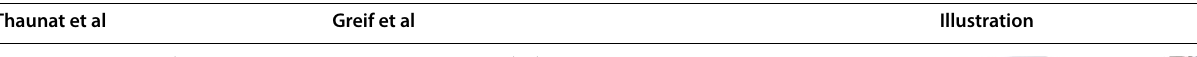
Table 1 Correlation between Thaunat’s and Greif’s classifications for meniscal ramp lesions, with corresponding illustrations Ramp lesion classifications Thaunat et al Greif et al